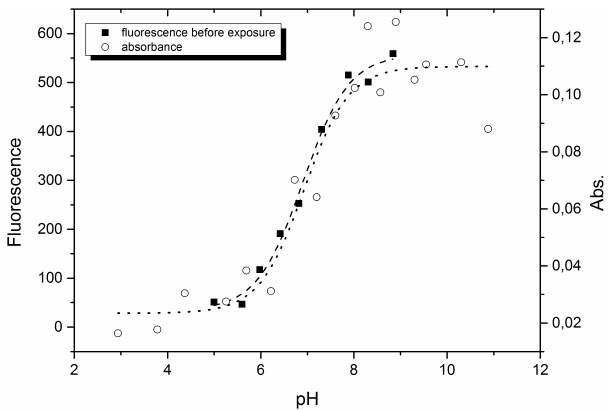
Fig. 6. E®ect of pH on °uorescence and absorbance of green form of SAASoti protein. Absorbance at 508 nm and °uores- cence at 500 nm. Measurements were performed in 20 mM Tris- HCl 100 MM NaCl 30 mM imidazole.